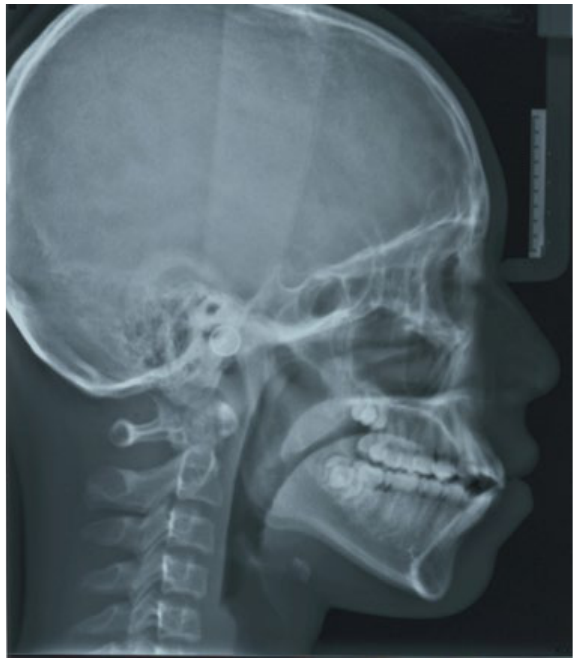
Figure 4. Pretreatment lateral cephalogram.